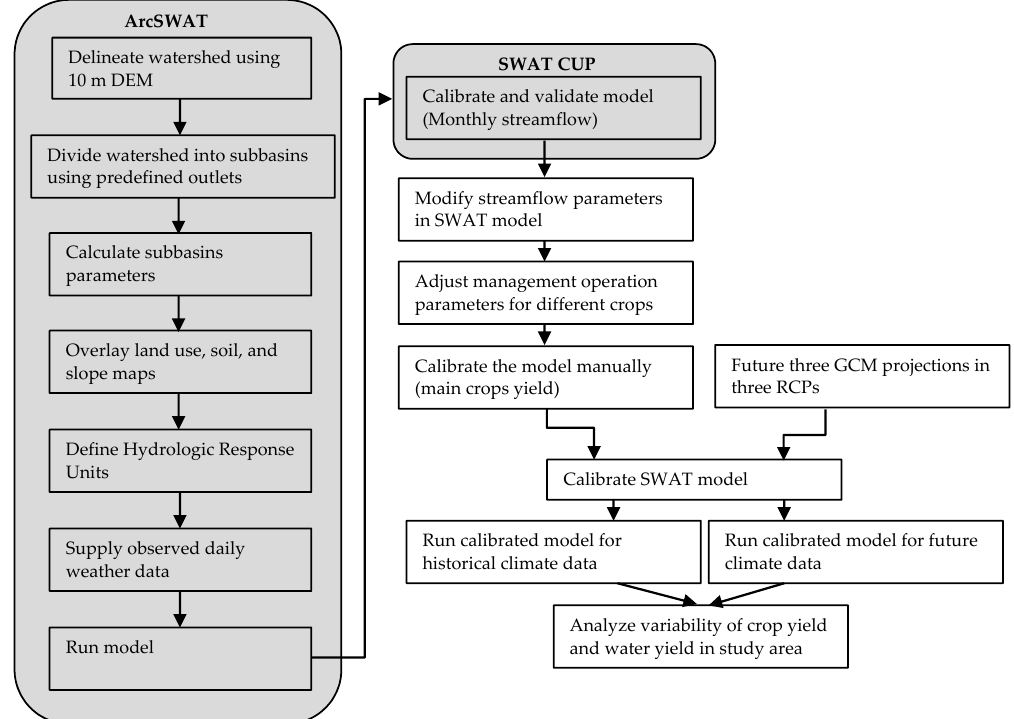
Figure 1. Conceptual model of integrated SWAT and climate model. DEM: Digital Elevation Model; GCM: General Circulation Model; and RCP: Representative Concentration Pathway.